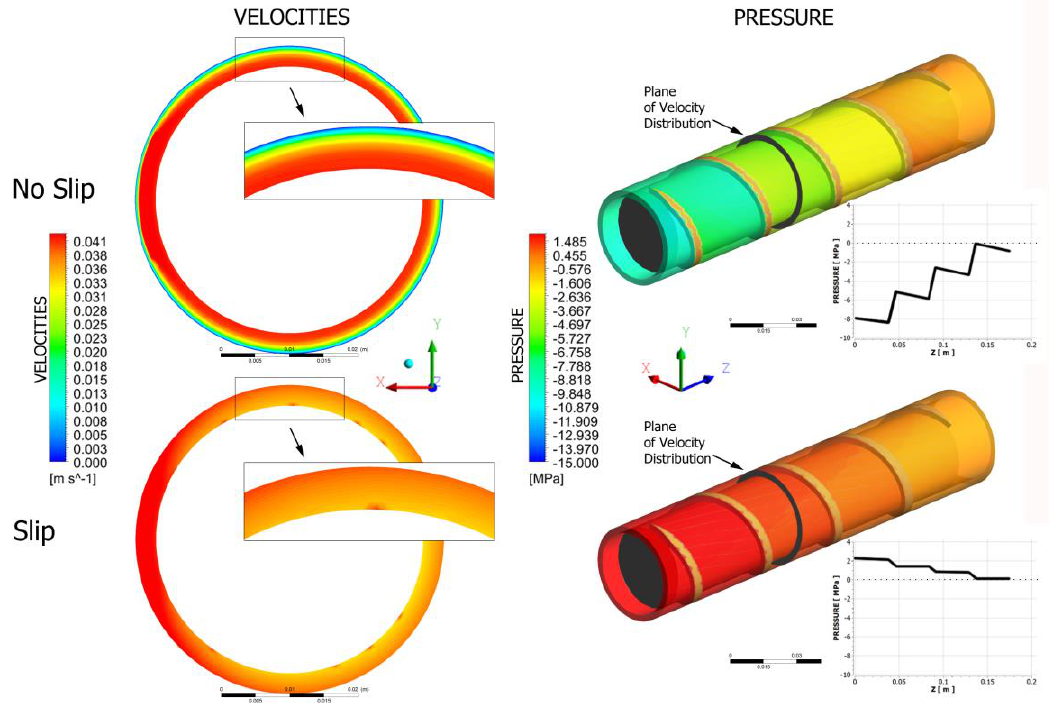
Figure 16. Screw flow simulations.